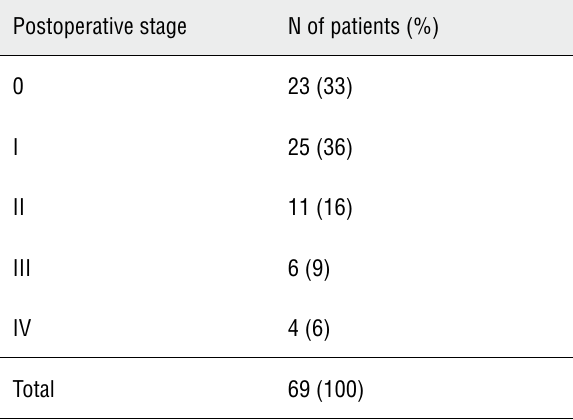
Table 2 - Shows postoperative stages AVWP.